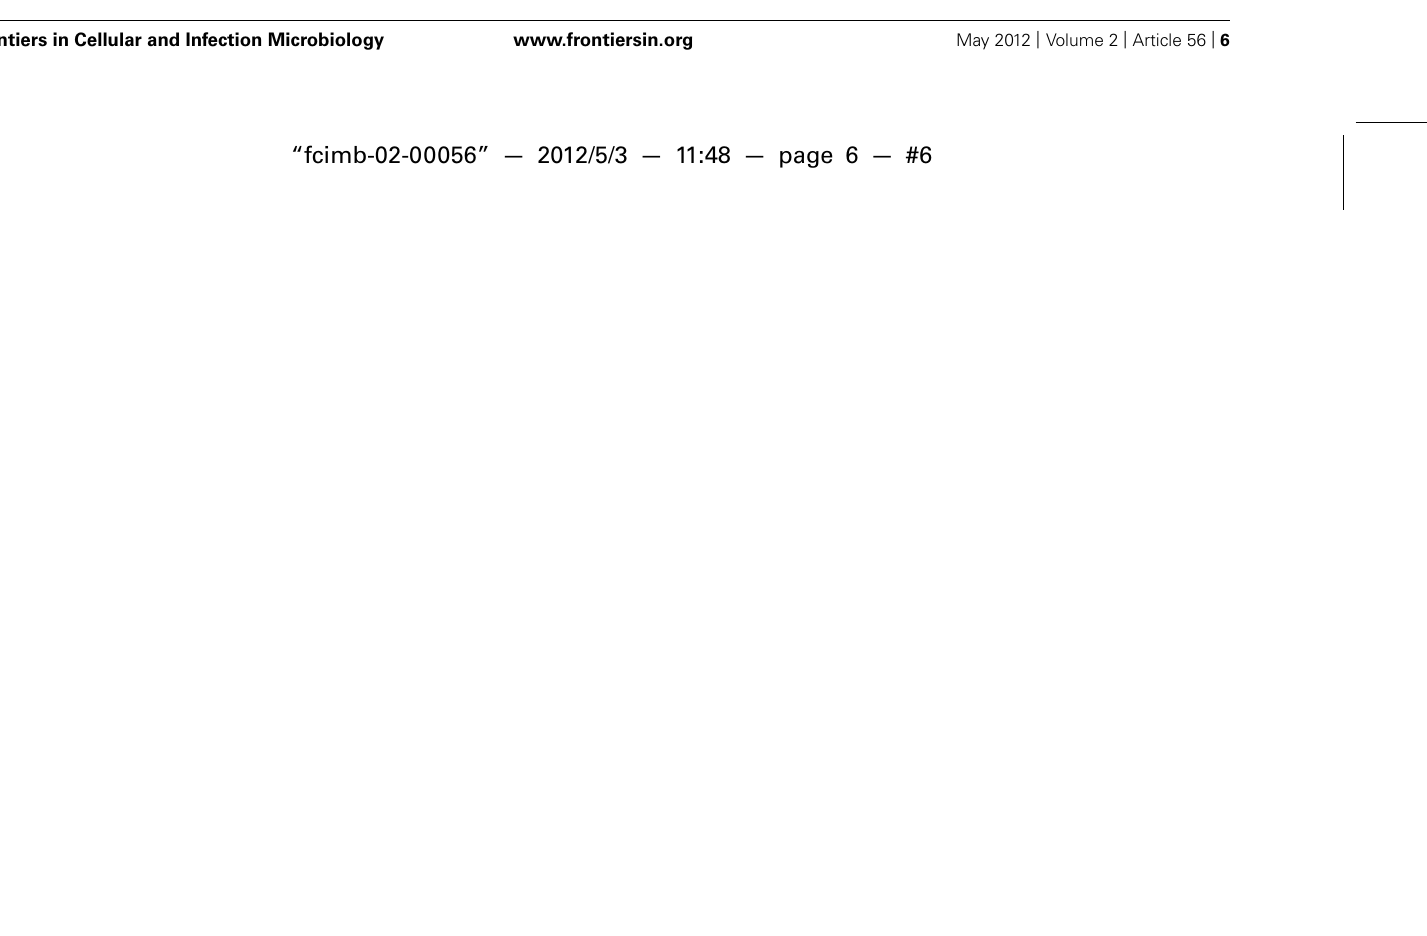
FIGURE 1 |A simplified overview of how a cell responds to the presence of S. aureus components. LTA and lipoproteins are recognized as PAMPs by cellular membrane boundTLRs such asTLR2:TLR1 orTLR2:TLR6.The activation ofTLRs results in recruitment of adaptors (e.g., MyD88) which via IRAKs activate signal cascades resulting in nuclear translocation of the transcription factor NF κ B.The nuclear localized NF κ B stimulates the transcription of AMPs and cytokines (e.g., IL-1 β ). Breakdown products from peptidoglycan (e.g., muramyl dipeptide) and other bacterial proteins (e.g.,